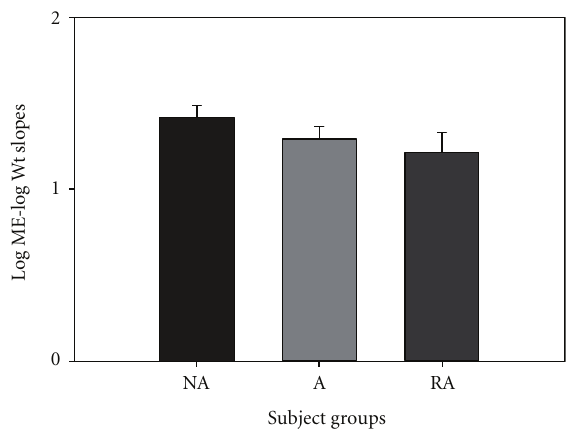
Figure 5: There was no significant di ff erence between the slopes for the 3 groups, NA, A, and LTA for visual grayscale magnitude esti- mation